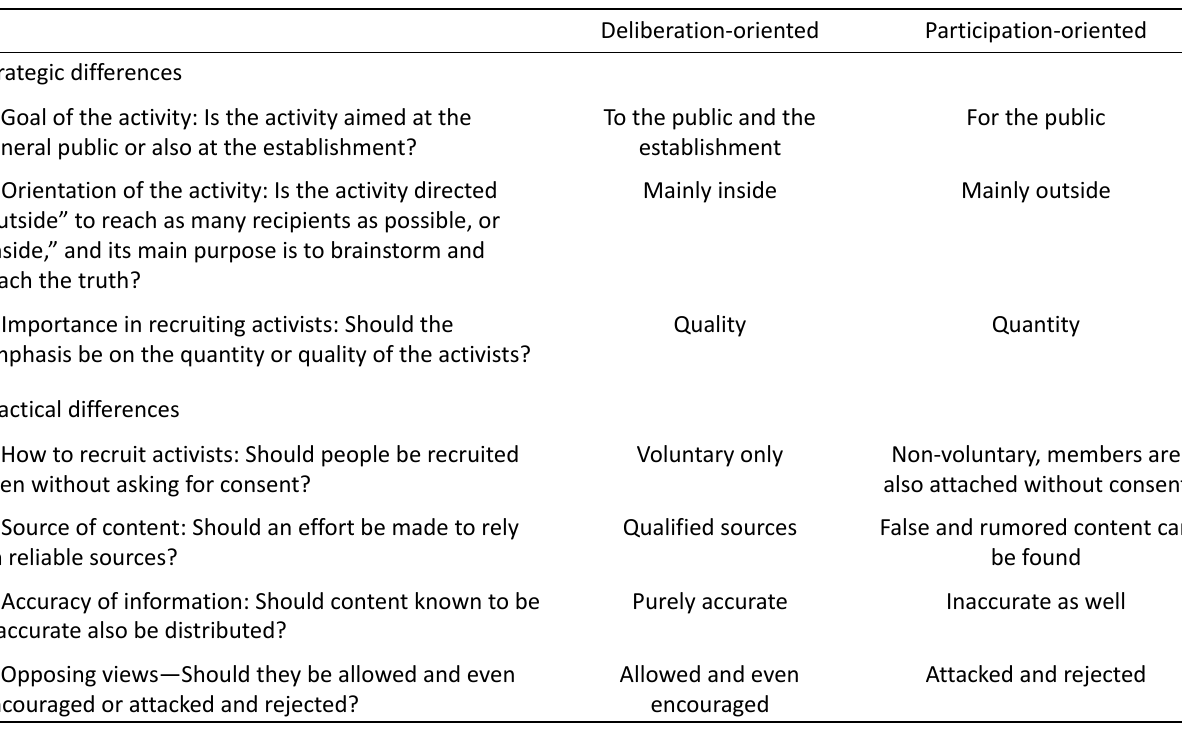
Table 1. Two clusters of admins and